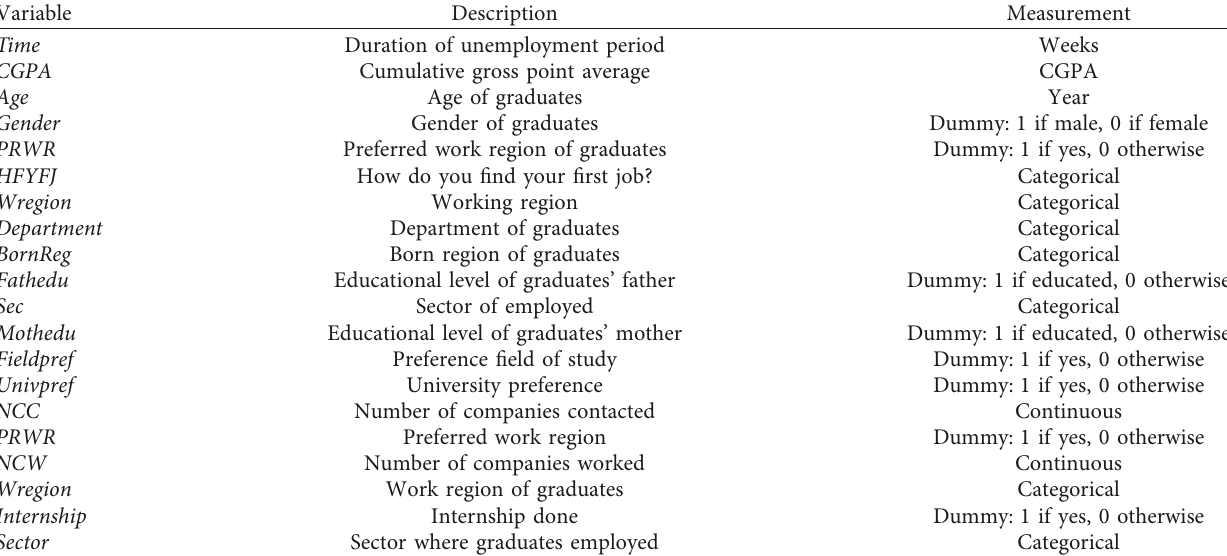
Figure 1: Employment status by department. Note: ABVM refers to agribusiness and value chain management; AcFn � accounting and finance; HORTI � horticulture; Plantsci � plant science; Magt � management. Table 2: Summary of definitions and measurements of variables